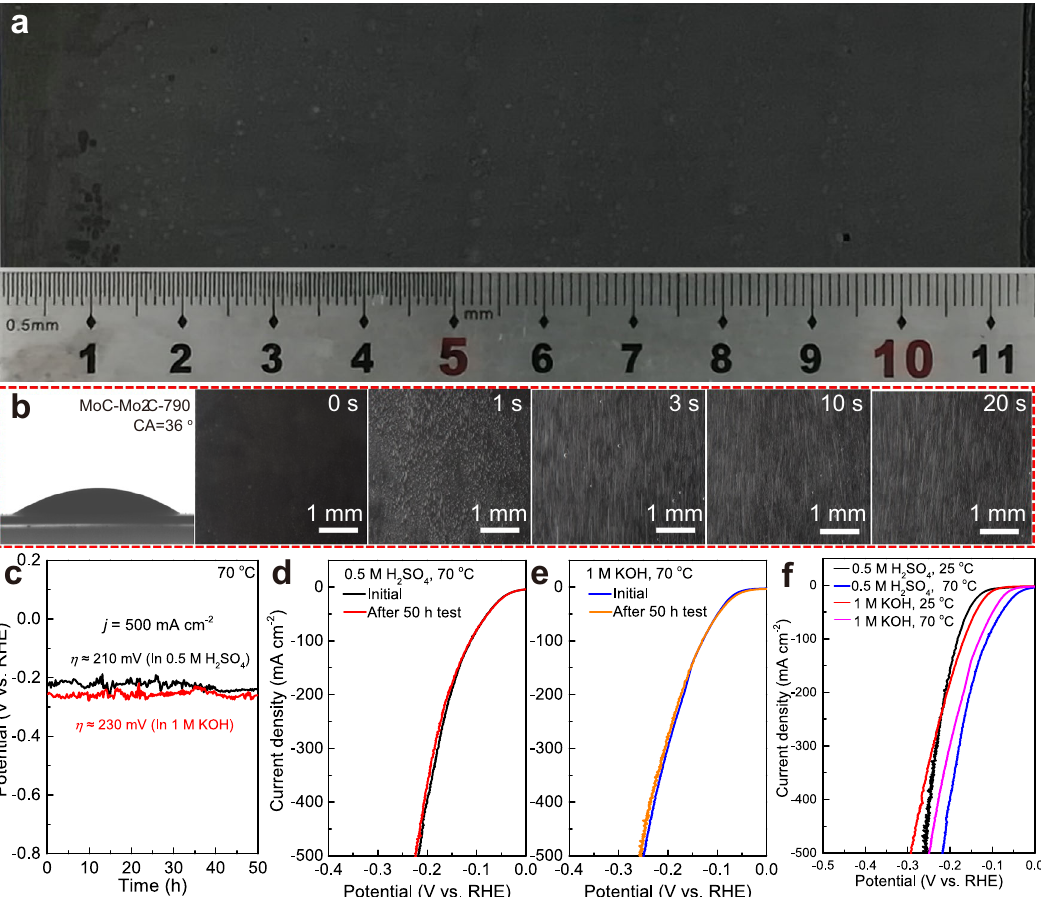
Fig. 5 Scale-up of the electrolysis and the HER performances of the large electrode operated at high current densities and high operating temperatures. a Digital image of the large MoC – Mo 2 C-790 electrode. b Contact angle image between water and the large MoC – Mo 2 C electrodes, and photos showing the H 2 bubble evolution process on the electrode. c Stability test at simulated industrial operating conditions in both 0.5 M H 2 SO 4 and 1 M KOH at 500 mA cm − 2 and 70 o C. LSV curves before and after stability tests at simulated industrial operating conditions ( d , e ). f LSV curves of the MoC-Mo 2 C-790 electrode in both acidic and alkaline solutions at 25 o C and 70 o